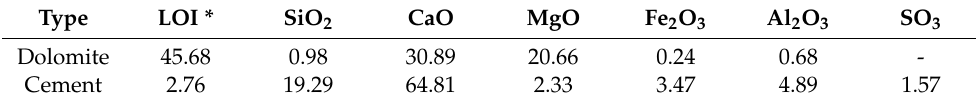
Table 1. Chemical composition of Portland cement clinker and dolomite.